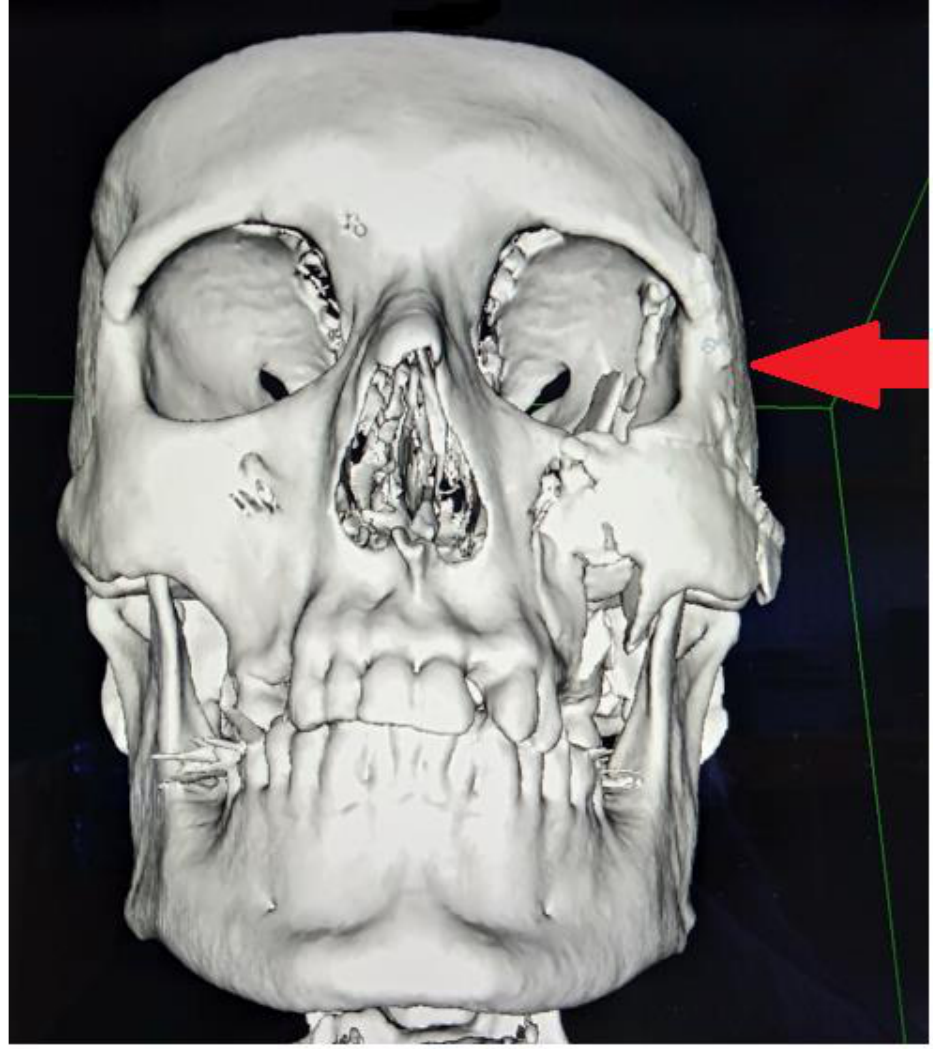
Figure 14. Postoperative frontal view 3D-CT evaluation indicated good position of the orbital walls and acceptable final results from stable bone osteosynthesis. Red arrow points on proper bone alignement.